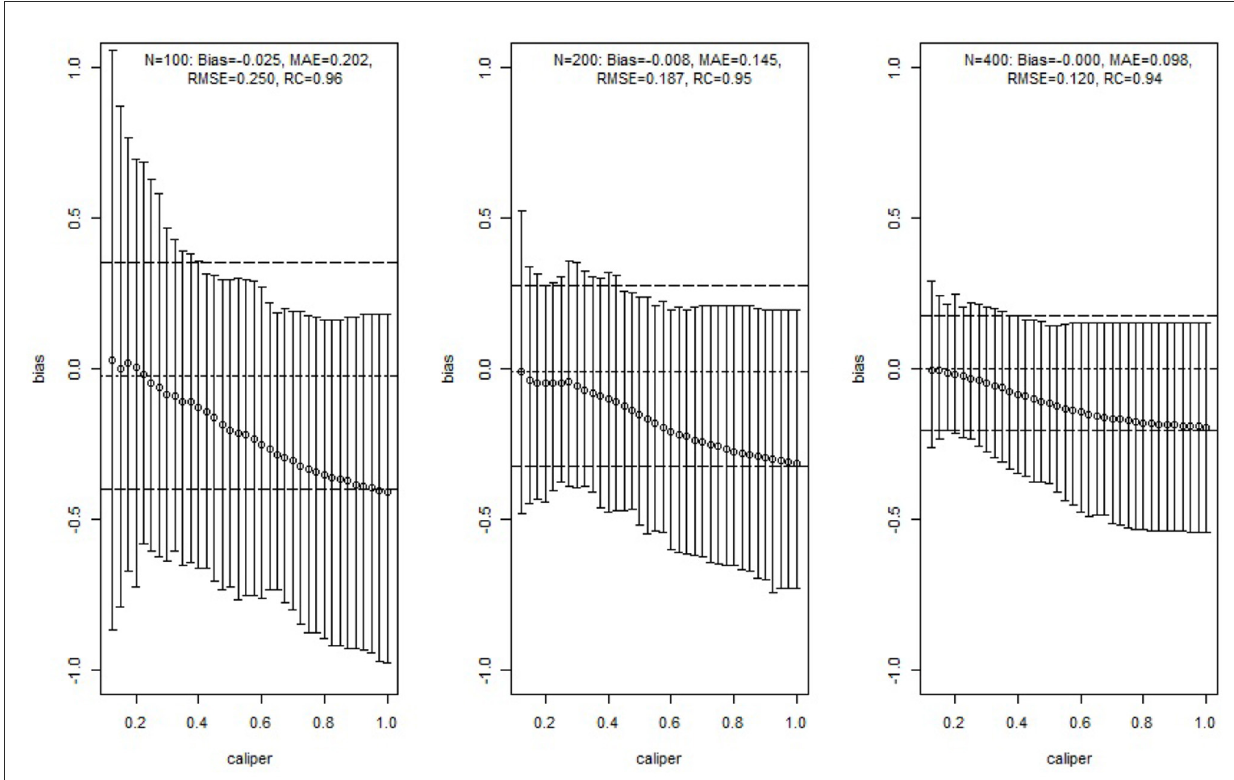
FIGURE3 Simulation study results of comparing GPMatch with Mahalanobis distance matching methods. The circles are the averaged biases of estimates of ATE using Mahalanobis matching with corresponding calipers. The corresponding vertical lines indicate the ranges between the 5th and 95th percentiles of the biases. The horizontal lines are the averaged ATE (short dashed line), and the 5th percentile and 95th percentile (long dashed line) of the biases of the estimates from GPMatch.